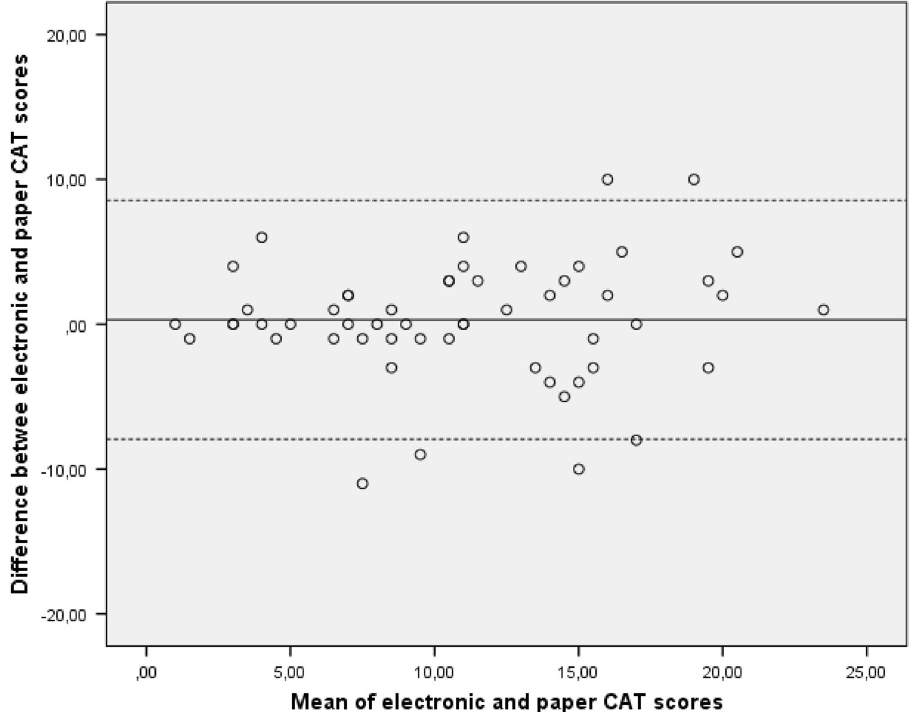
Fig. 3 Bland – Altman plot showing the relationship between the electronic and paper version of the CAT. The dashed lines represent the limits of